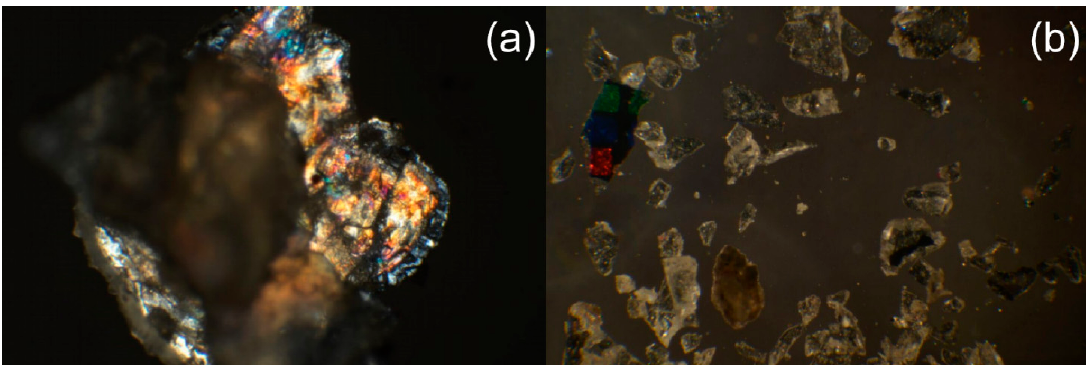
Figure 3. Polarized microscope photos of LCD panel scraps ( a ) before the grinding and ( b ) after treatment up to a size <1 mm. Absence of iridescence confirms pretreatment effectiveness with liquid crystal degradation.